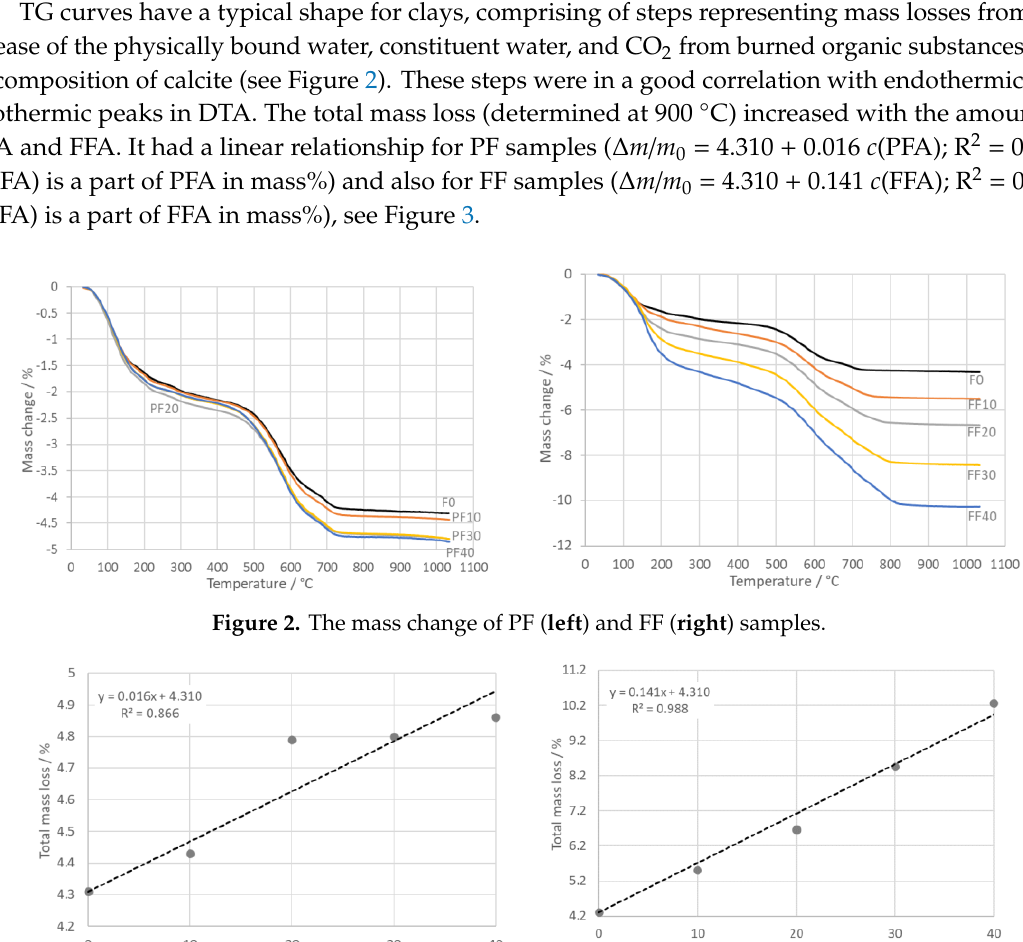
Figure 4. The thermal expansion of PF ( left ) and FF ( right ) samples (dashed lines correspond to the cooling stage of the firing).